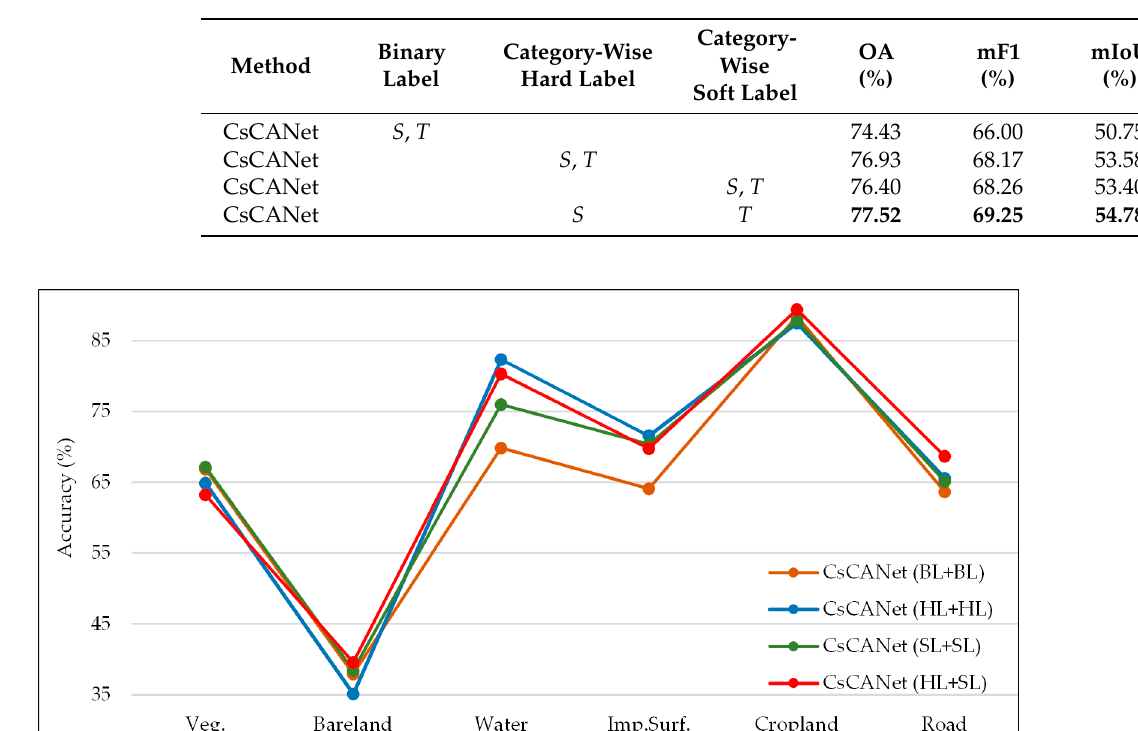
Figure 9. Per-class accuracies for land cover mapping. BL, HL, and SL, respectively, denote the binary label, category-wise hard label, and soft label. For all the categories, each method with a specific extraction module for domain labels corresponds to a broken line with a particular color.